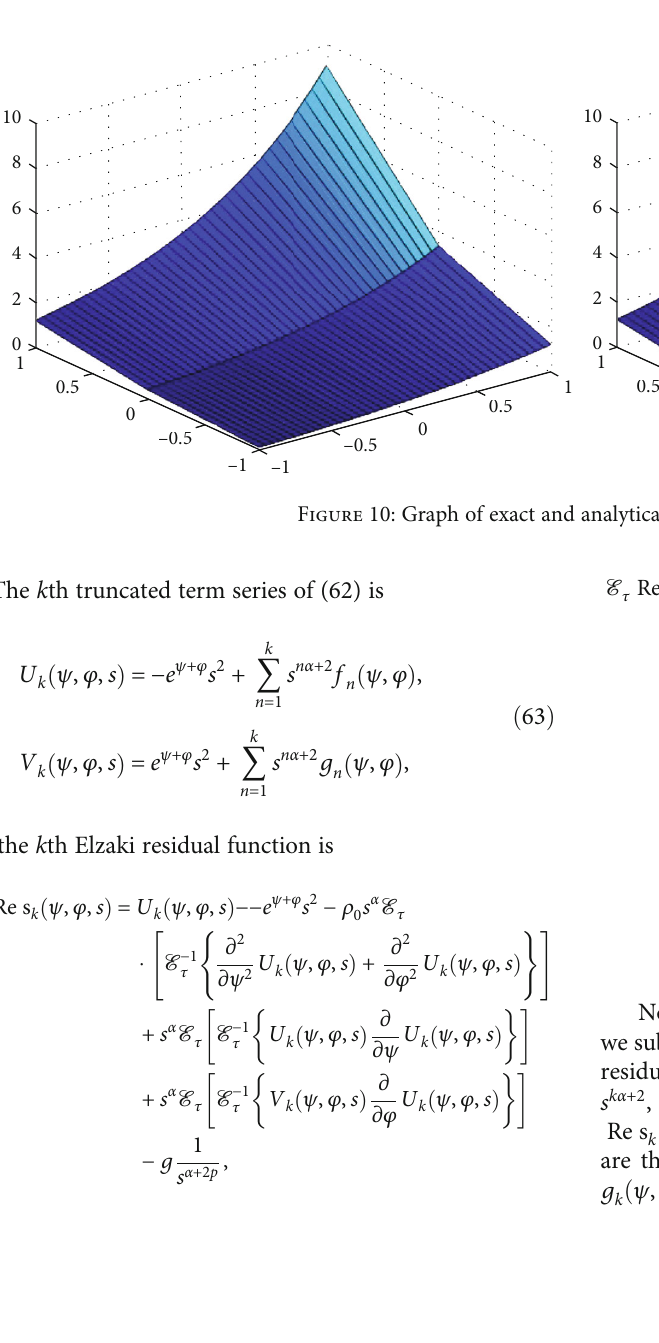
Figure 9: Graph of exact and analytical results of Problem 4.